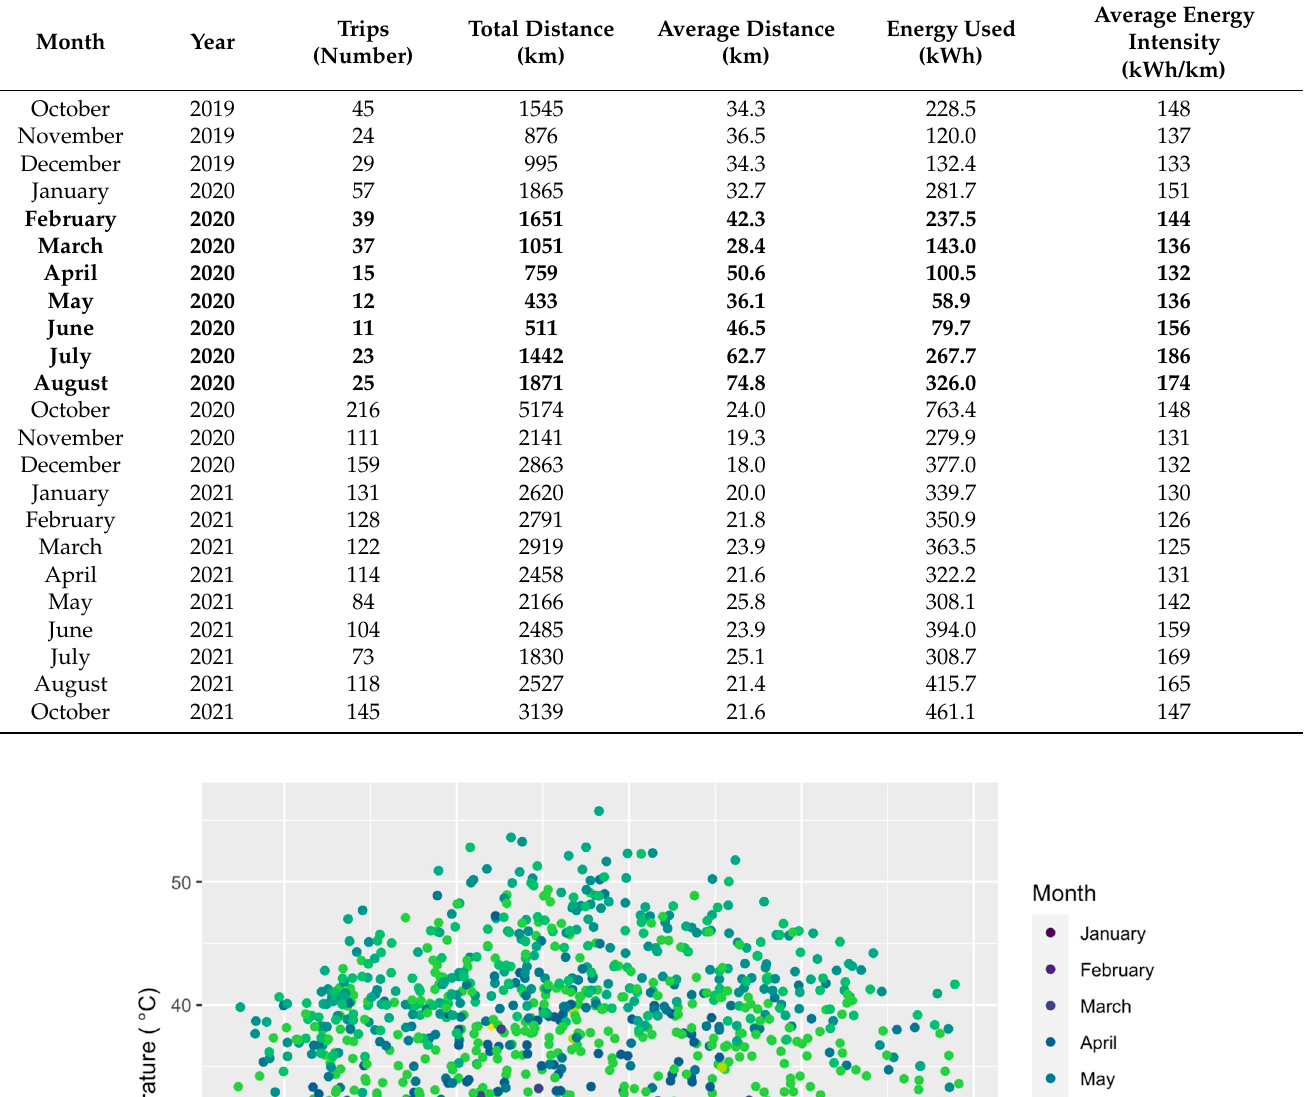
Table 3. Summary of recorded car journeys by month. Figures in bold indicate data collected during periods when government-mandated restrictions (full or partial lockdown/curfew) were in place.